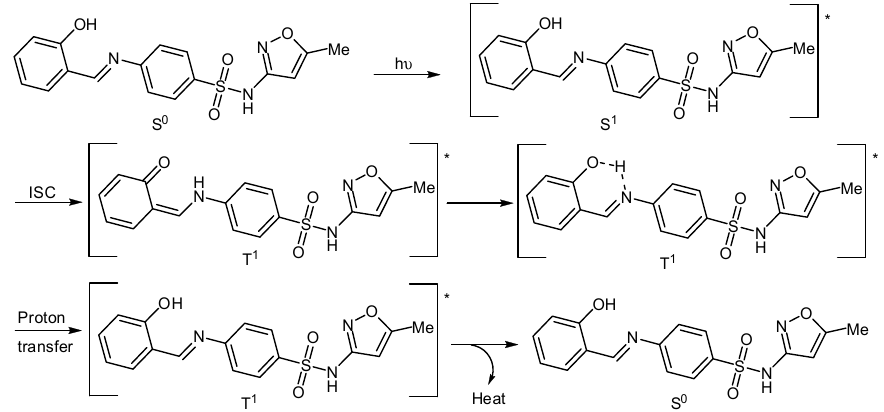
Scheme 4. Possible photostabilization of PVC films through a proton transfer and intersystem crossing (ISC) in the presence of Schiff’s base 1 .